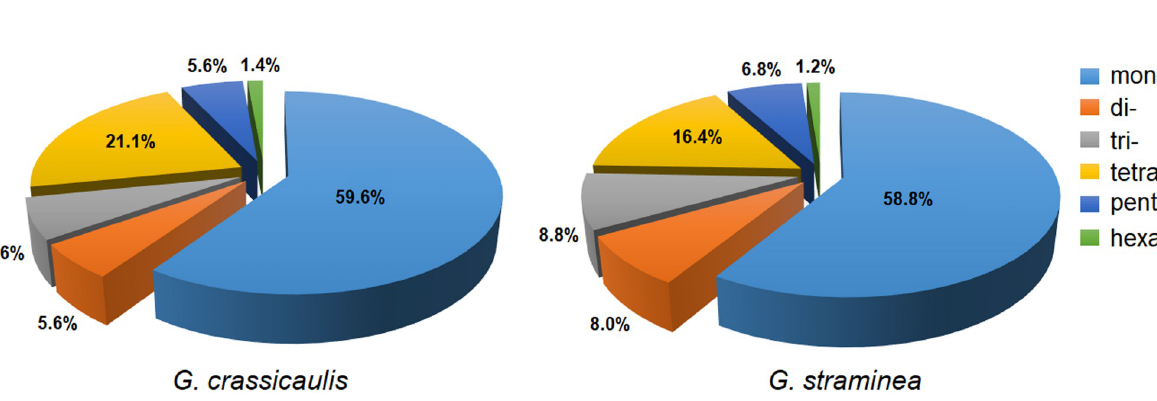
PLOS ONE | https://doi.org/10.1371/journal.pone.0281134 January 26, 2023 8 /